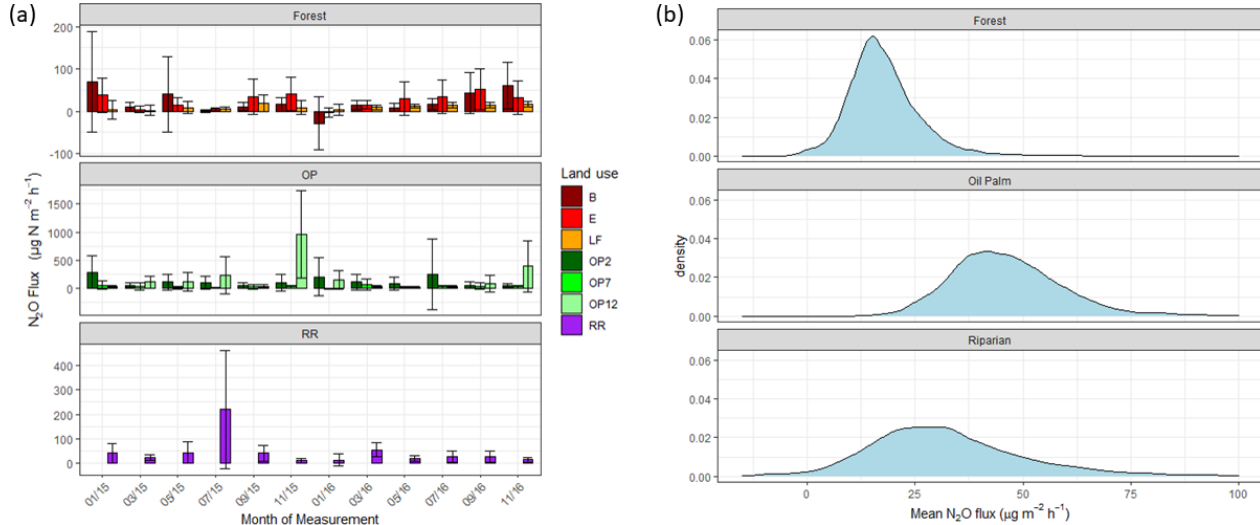
Figure 4. (a) Nitrous oxide (N 2 O-N) fluxes in µgm − 2 h − 1 from January 2015–November 2016, every 2 months (upper panel – B, E, LF: logged forests; middle panel – OP2, OP7, OP12: oil palm plantations; bottom panel – RR: riparian reserve). Bars are the mean for each site, and error bars are the standard deviation of number of chambers per site. Please note different y -axis scales for each land use. (b) Posterior probability density of the mean nitrous oxide flux from each land use, estimated by the Bayesian GLMM described in the text.